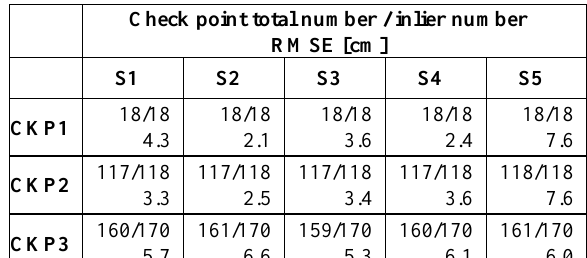
Figure 18. 3D distances between CKP2 set and the scenario